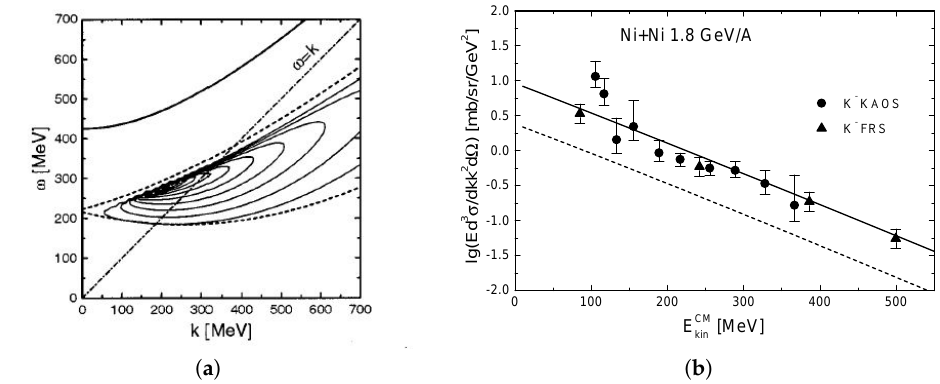
Figure 10. Figure from [49]. ( a ) spectral density of K − excitations in ISM at saturation. The upper curve shows the position of the quasiparticle kaon branch. Dashed curves border the ( Λ p − 1 ) continuum. Thin lines between them depict the ascending levels of kaon spectral density; ( b ) invariant differential cross section of K − production in Ni+Ni collisions with energy 1.8 GeV per nucleon as the function of the kaon kinetic energy in the center-of-mass system in comparison with experimental data [60,61]. The solid line depicts calculations with the in-medium spectral density, and the dashed line shows the results for the free kaon